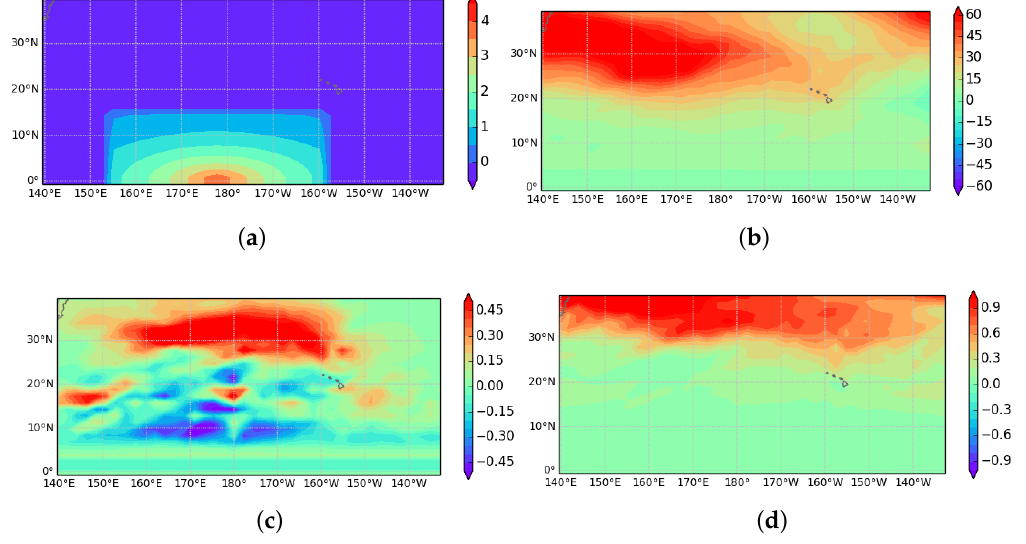
Figure 3. ( a ) Heating rate at 4000 m, units ◦ K day − 1 ; ( b ) zonal geostrophic wind units ms − 1 at 11,500 m; ( c ) diagnosed zonal geostrophic wind tendency at 11,500 m, units ms − 2 ; and ( d ) (22) coefficient of BQ ’ matrix, Equation (21), at 11,500 m, units 10 8 × s − 2